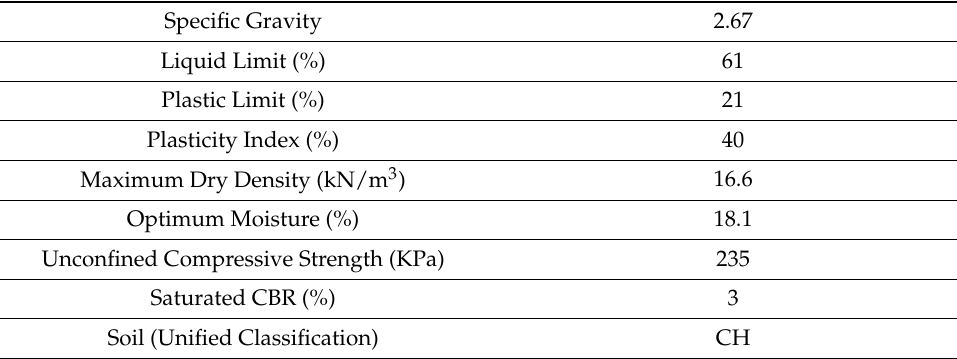
Table 2. Chemical composition of materials used. Table 1. Geotechnical properties of the soil.